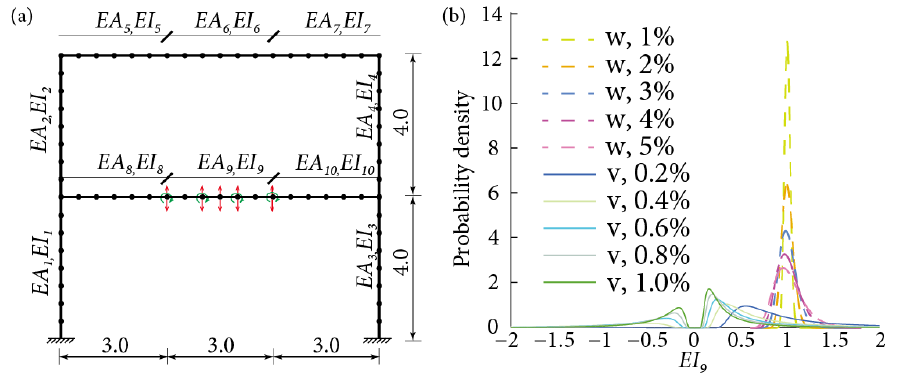
Figure 7. ( a ) FEM for a two-story one-bay frame (arrows denote deflections, arcs denote rotations). ( b ) The distributions of the estimations using rotations ( w ) or deflections ( v ) under different error levels (indicated in the brackets).